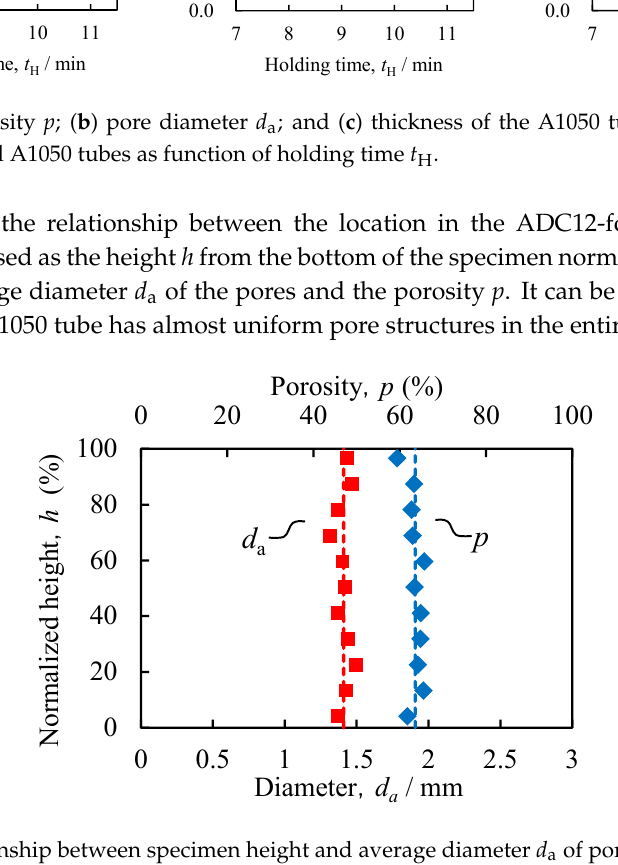
a of pores and porosity p